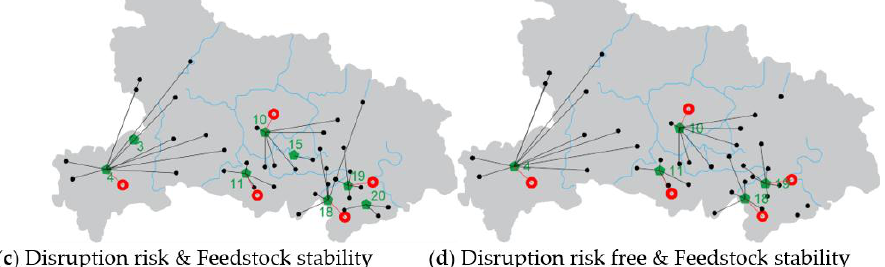
Figure 9. Optimal facility locations for the four cases. ( a ) Disruption risk and feedstock seasonality; ( b ) Disruption risk free and feedstock seasonality; ( c ) Disruption risk and feedstock stability; ( d ) Disruption risk free and feedstock stability.